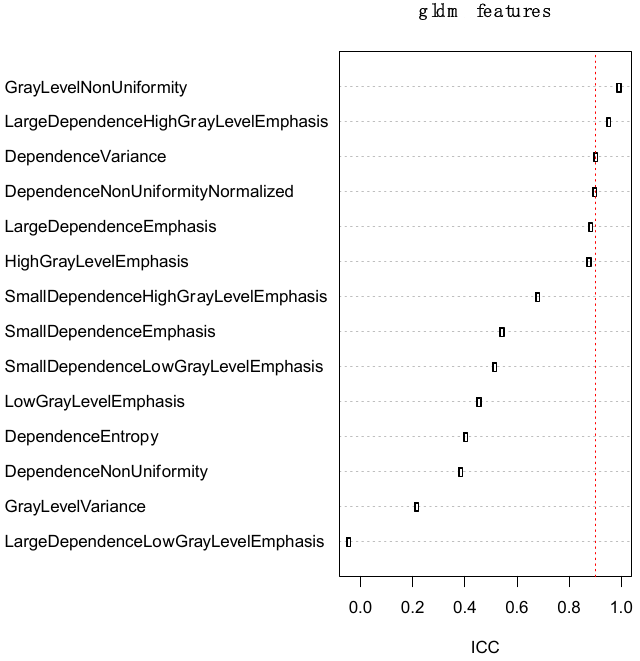
Figure 5. Robustness of second-order GLDM features across segmentations. Pyradiomics computes 14 second-order GLDM features. The robustness (ICC) is above 0.8, per all values of distance and binw, only for nine of them. Robustness of many features across segmentations is dependent on bin-width and distance (the vertical dashed red line indicates the 0.9 threshold).